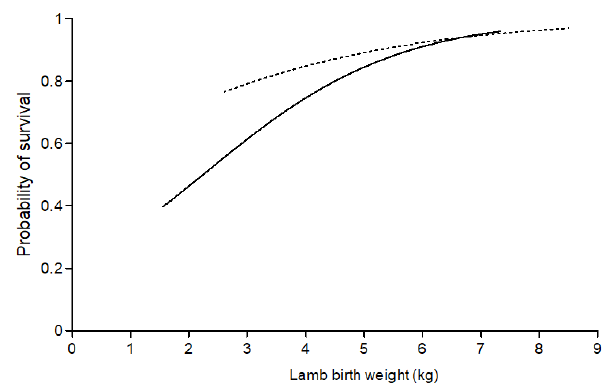
Figure 2. The effect of lamb birth weight (kg) on the probability of survival for twin-(- -) and triplet-born (—) lambs (values are